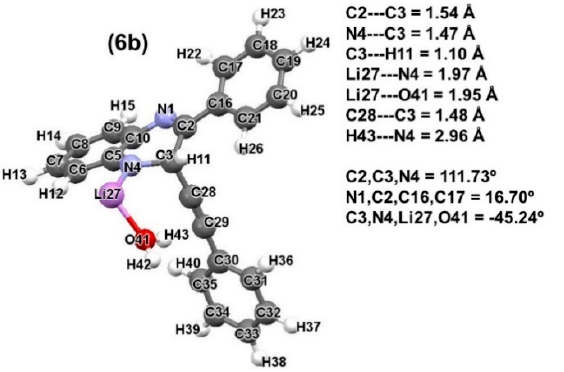
Figure 5. Global minimum structures of adducts 6a and 6b formed between a water molecule and intermediates 5a and 5b . Important distances, angles, and dihedral angles are given in Å and °, respectively. Table 5. Calculated energies ( E , E ZPVE , H, and G in au) of all stationary points observed in the hydrolysis of 5a and 5b . The relative energies ( ∆ , in kcal mol − 1 ) denoting the energy difference between the computed energies of the stationary points and the total sum of the energies of the reactants is also included.